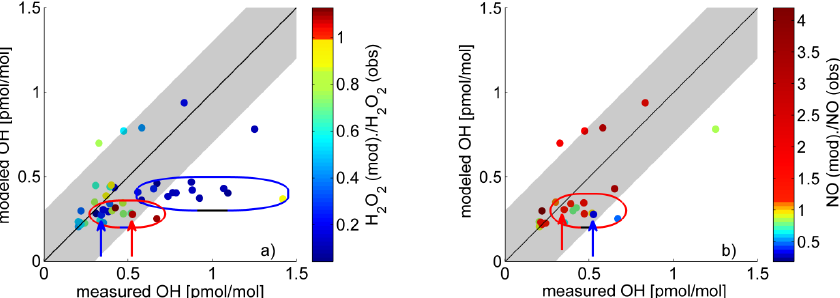
Fig. 10. Highlighted are underestimated OH mixing ratios at underestimated H 2 O 2 mixing ratios (blue ellipse). Within the red ellipse some data points show slightly underestimated OH at relatively well reproduced H 2 O 2 but severely underestimated NO, while at other times OH was reasonably reproduced even though H 2 O 2 mixing ratios in the model were much too low and NO was overestimated. Figure 10a is a cut-out of Fig. 9c. To highlight the statement the colour coding was adapted.